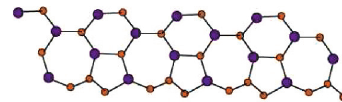
Figure 4: Si Table 1: Degree-based edge partition of Si